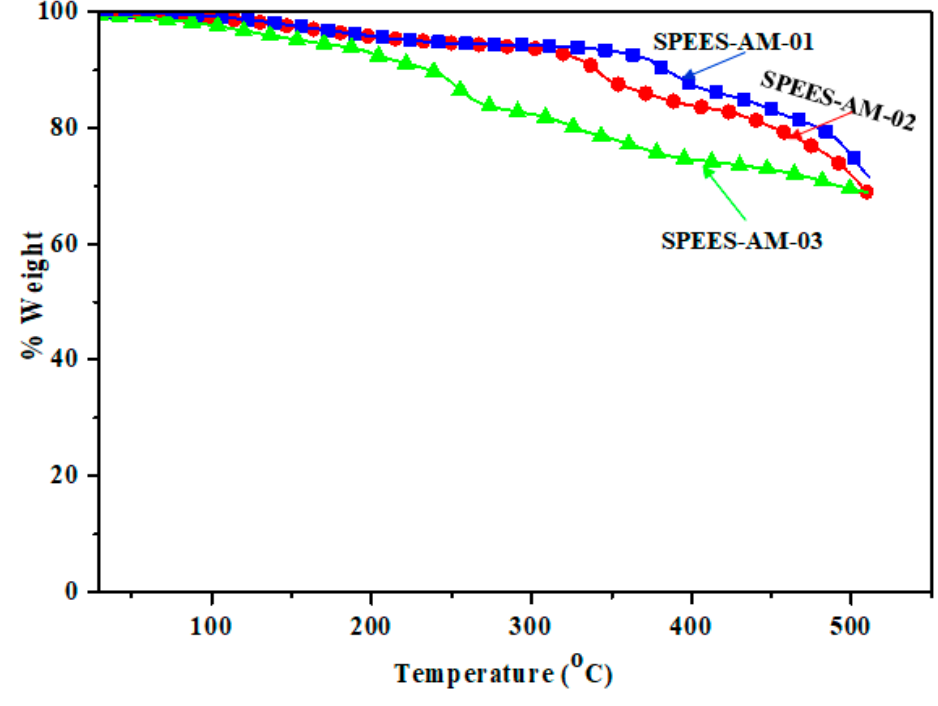
Figure 7. TGA for SPEES-AM membranes.